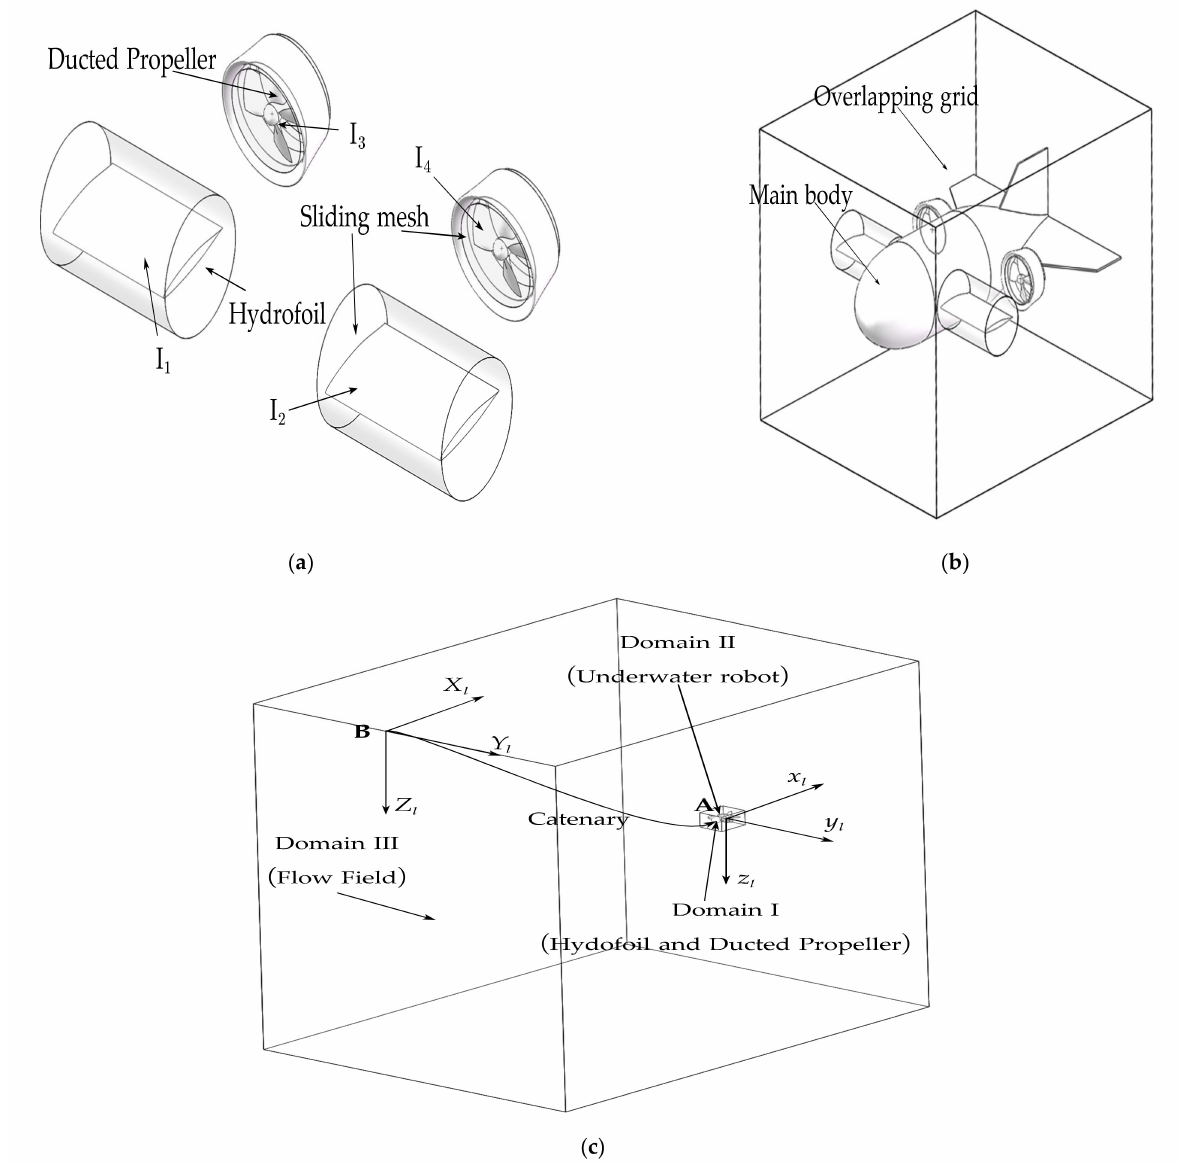
Figure 4. Computational domain of the underwater robot: ( a ) Domain I: propeller and hydrofoil; ( b ) Domain II: underwater robot; ( c ) distribution of the computational